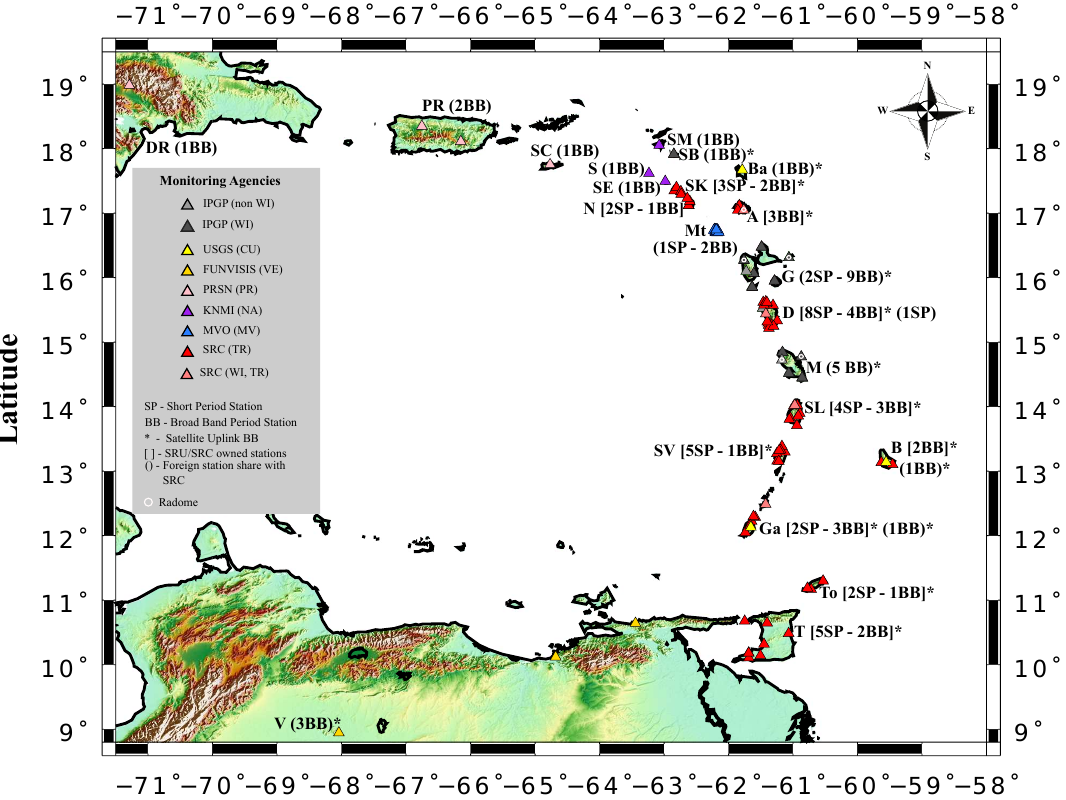
Figure 10. 2018 map of the location of the SRC seismic stations and the shared seismic stations from other regional monitoring agencies that are used by the SRC to monitor volcanic and